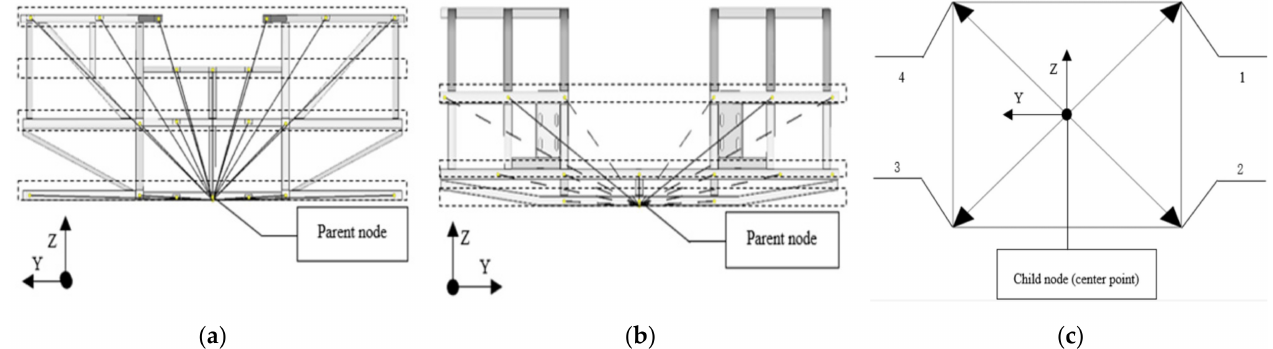
Figure 3. ( a ) Node network of plug interface; the parent node represents the center point and each child node represents one of the pre-connected structural components. Shown is the front view of a middle frame module and the plug interface; ( b ) Node network of socket interface; the parent node represents the center point and each child node represents one of the pre-connected structural components. Shown is the front view of a rear suspension frame module and the socket interface; ( c ) Creation and identification of the feature points of a regular structural component section. shown is a cross-section diagram of a truss of the plug